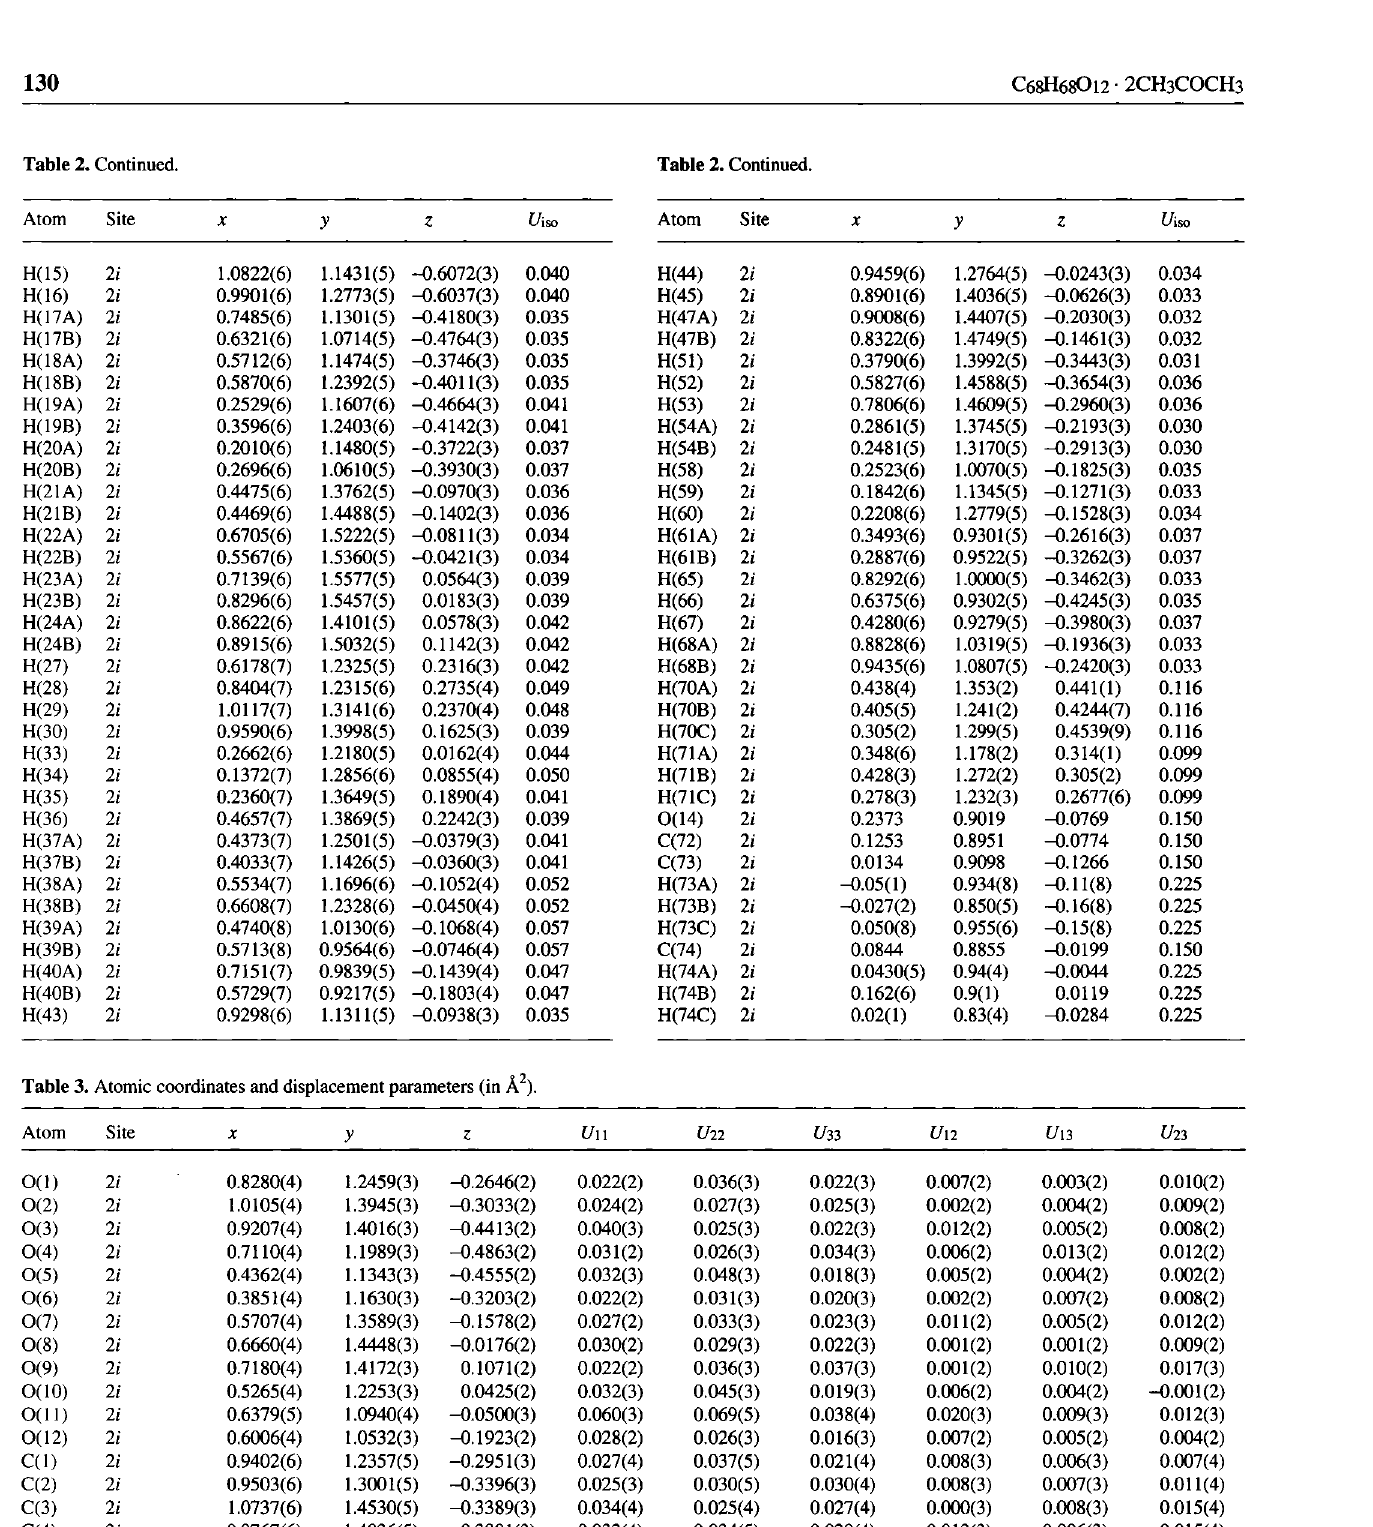
Table 3. Atomic coordinates and displacement parameters